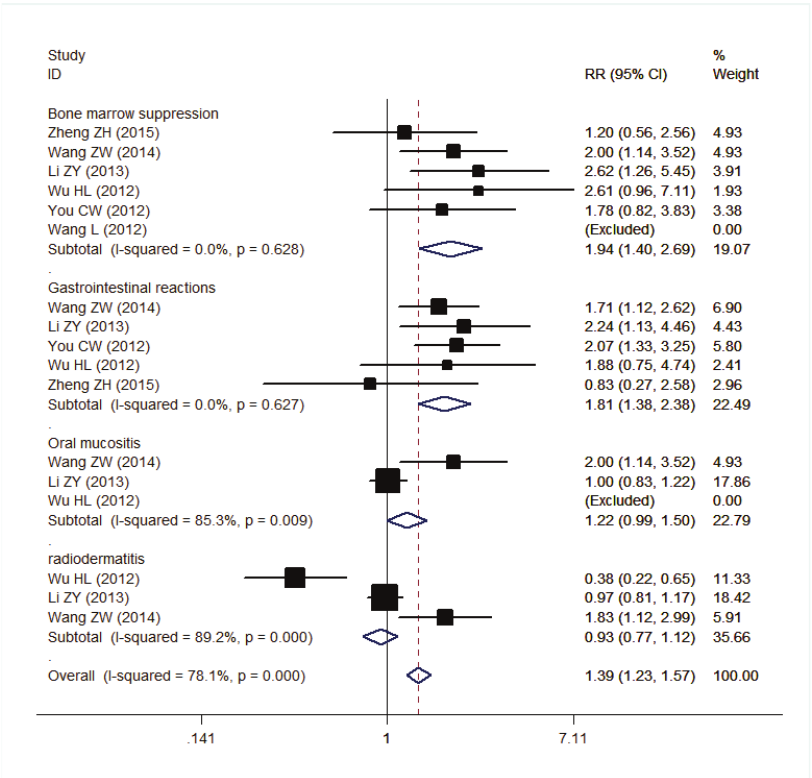
Figure 4: Forrest plot evaluation treatment related toxicity of S-1 combined with radiotherapy versus radiotherapy